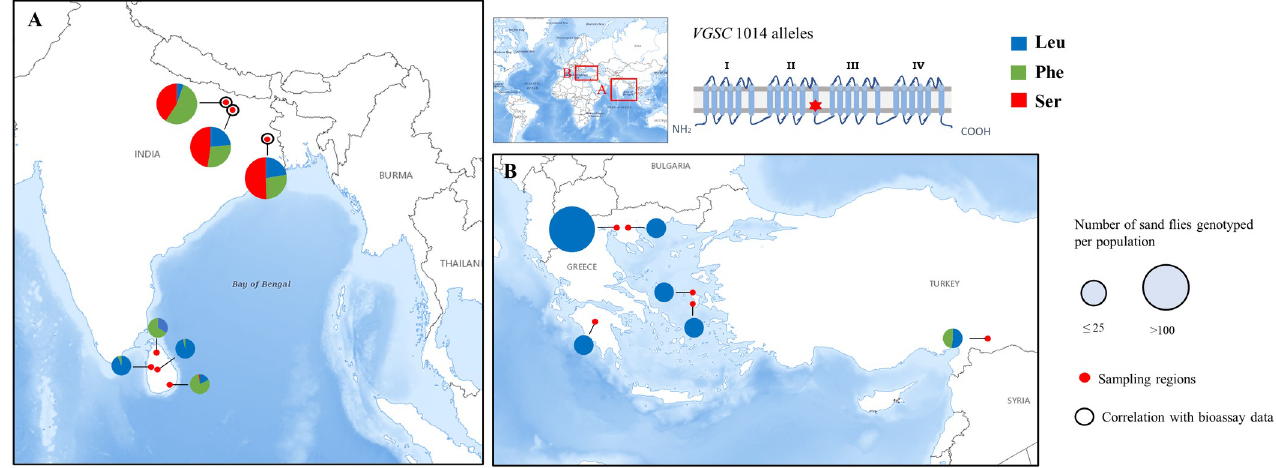
Fig 2. Global geographical distribution and respective allelic frequencies (%) of the kdr mutations at VGSC locus 1014 in sand fly populations. Molecular analyses refer to (A) P . argentipes populations from India and Sri Lanka and (B) mixed Phlebotomus spp. populations from Greece and P . papatasi populations from Turkey. The size of the pie charts is proportional to the number of specimens genotyped per population. Red dots denote the sampling regions in the 4 countries. Genotyping data correlated with results of bioassay experiments are marked with a black circle. The allelic frequencies, the number of total specimens analyzed per population, and the species included are given in detail in S2 Table. Maps were obtained from USGS (https://apps.nationalmap.gov/viewer/). kdr , knockdown resistance; Leu, leucine (wild-type allele); Phe, phenylalanine (mutant allele); Ser, serine (mutant allele); USGS, US Geological Survey; VGSC , voltage-gated sodium